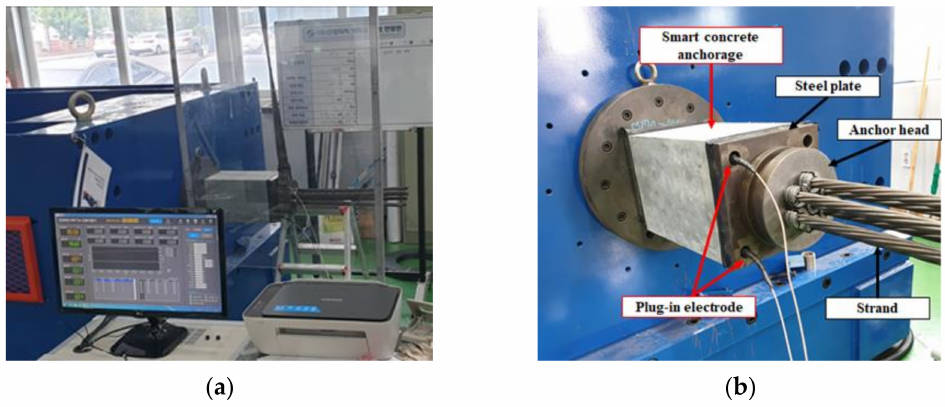
Figure 8. Test setup of the SCA for monitoring pre-stress loss: ( a ) test setup; ( b )